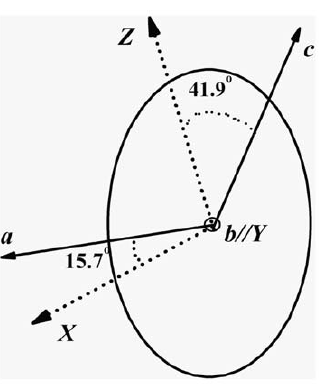
Figure 3. Orientation of principal axes X , Y , Z to the a-,b- and c - axis for Yb 3 + :KBaGd(MoO 4 ) 3 crystal.